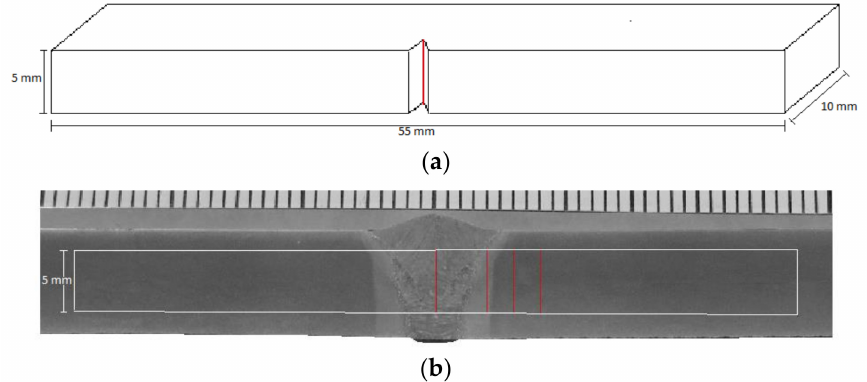
Figure 4. Charpy-V impact test specimens: ( a ) dimension; ( b ) notch locations with red vertical lines representing the locations: WM (weld metal), FL (fusion line) + 1 mm, FL + 3 mm and FL + 5